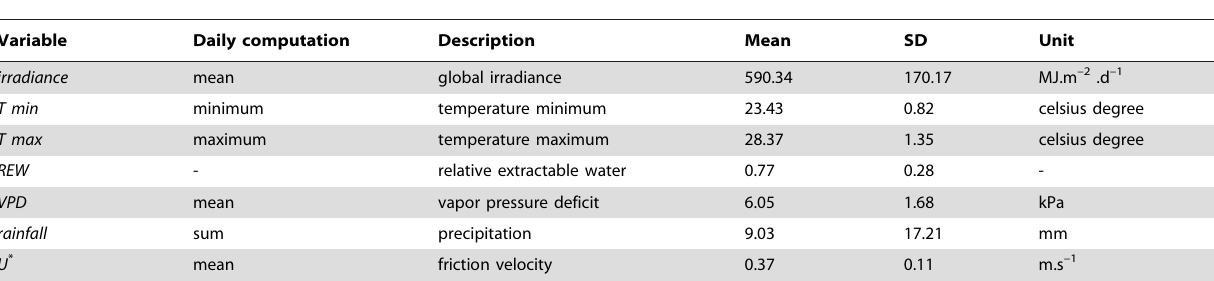
Table 2. Descriptive statistics of the climate variables from 2007 to